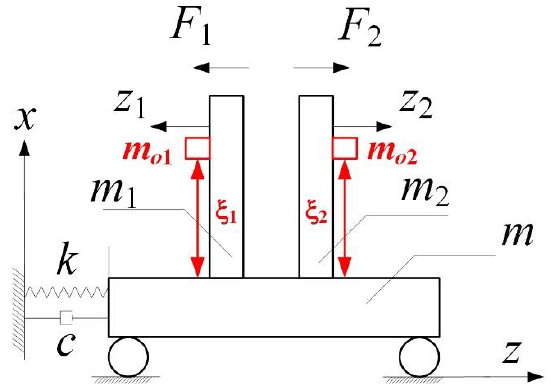
Figure 3. Double-beam coupled vibration model with additional mass. 132